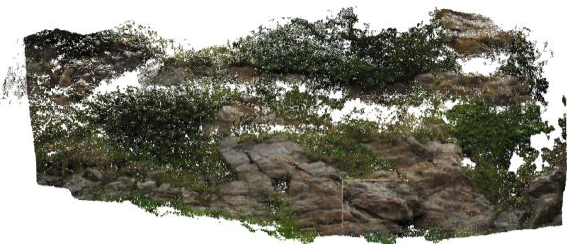
Figure 16. SURE GoPro dense point cloud